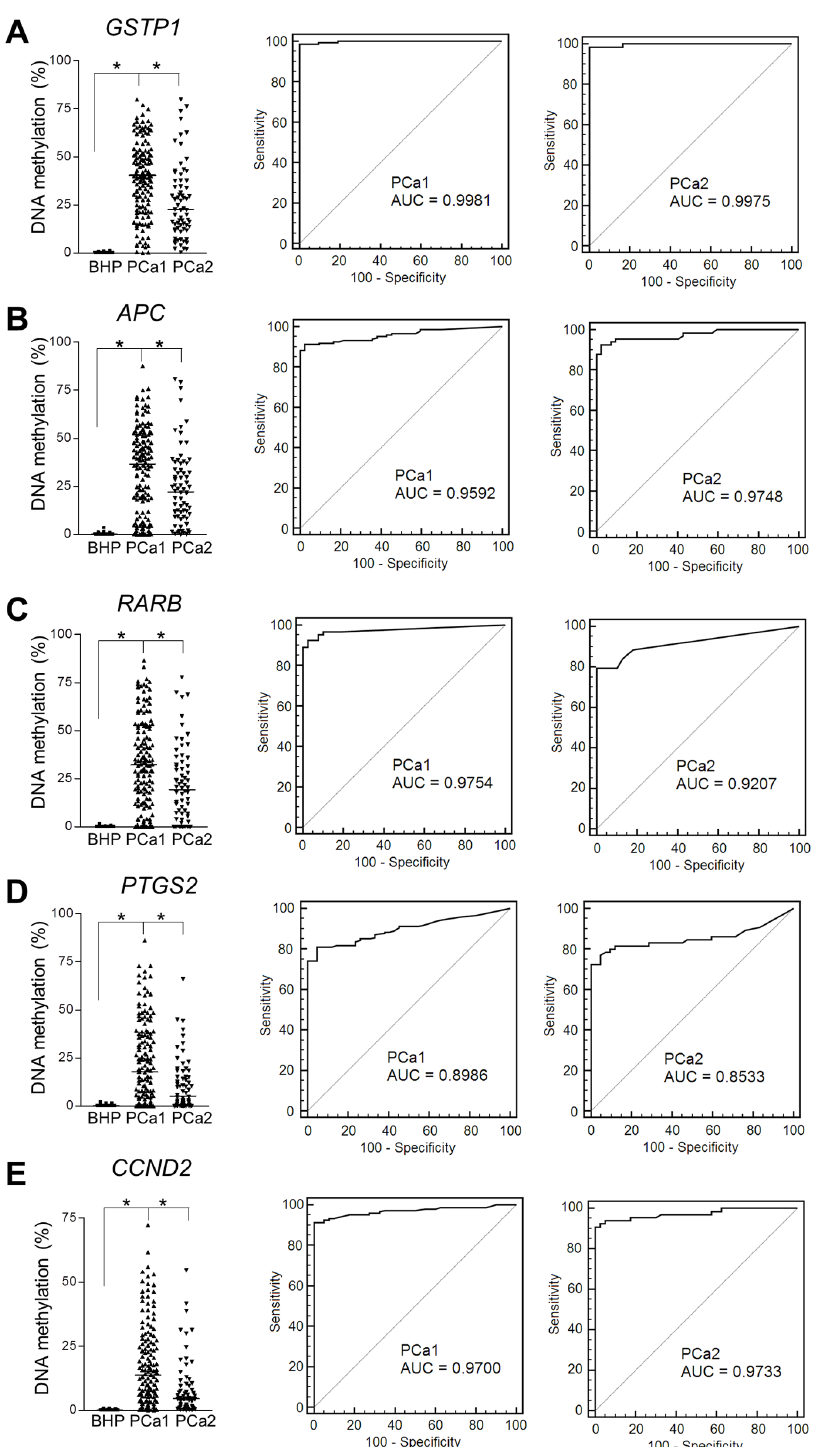
Fig 1. Comparison of DNA-marker methylation in benign prostatic hyperplasia (BPH) and high-risk PCa. The methylation of RARB , GSTP1 , APC , CCND2 and PTGS2 was determined by QM-MSP in radical prostatectomy samples from 42 patients with BPH and from 147 (PCa1) and 71 (PCa2) patients with high-risk PCa. The data are shown in dot plots for the indicated genes (A-E, left graphs). Methylation levels of every gene in each PCa cohort were significantly higher than in the BPH group, as determined by the